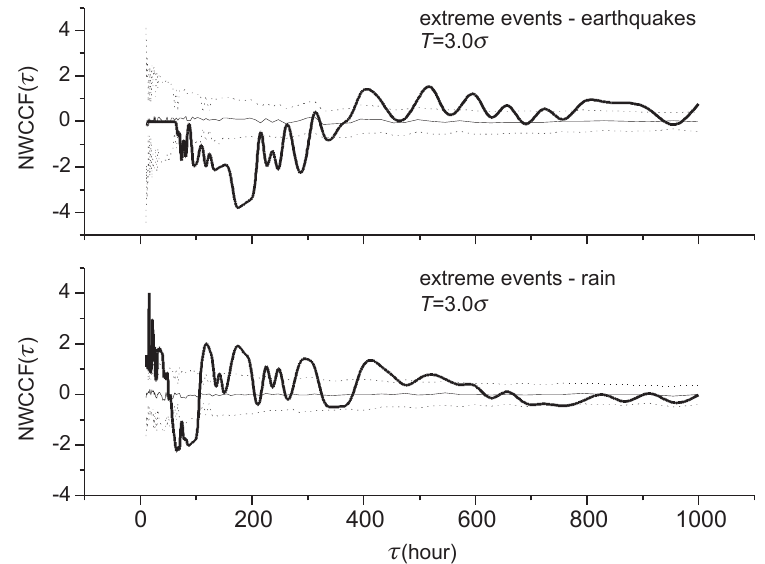
Fig. 6. NWCCF( τ ) ∼ τ relation for EE-EQ and EE-RR pairs, with T = 3.0 σ